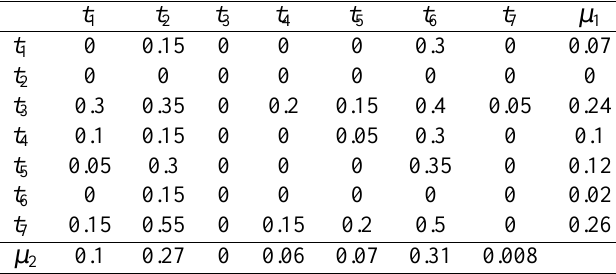
Table 5. Outranking degrees (Example 3a).